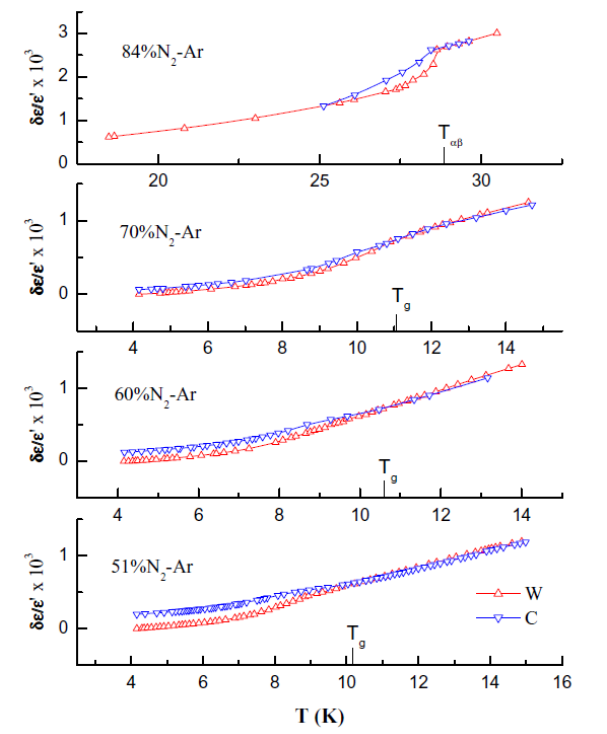
Figure 20. Thermal cycling of dielectric susceptibility measurements of solid N 2 -Ar mixtures by Pilla et al.[57]. Reproduced with permission from [57]. Copyright Institute of Physics,